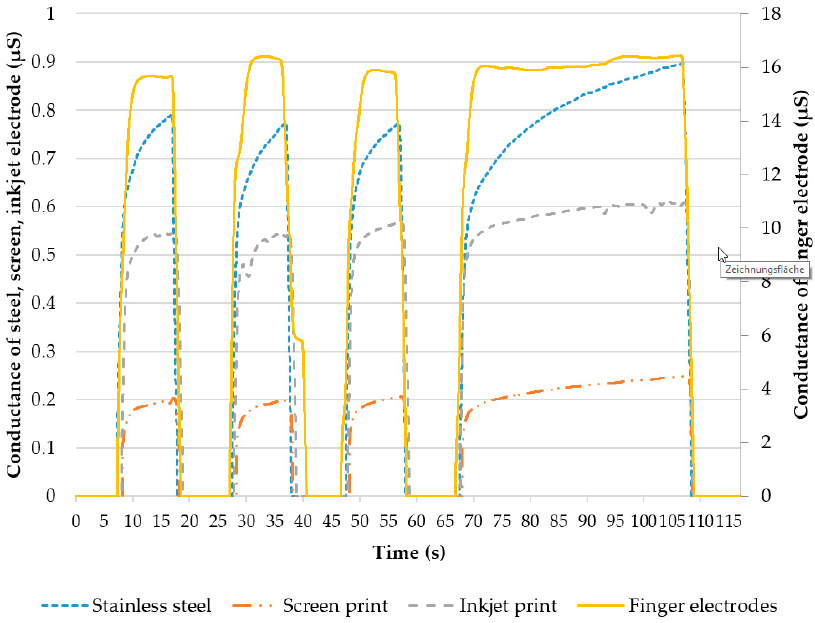
Figure 9. Comparison of screen- and inkjet-printed electrode modules and stainless steel and standard finger